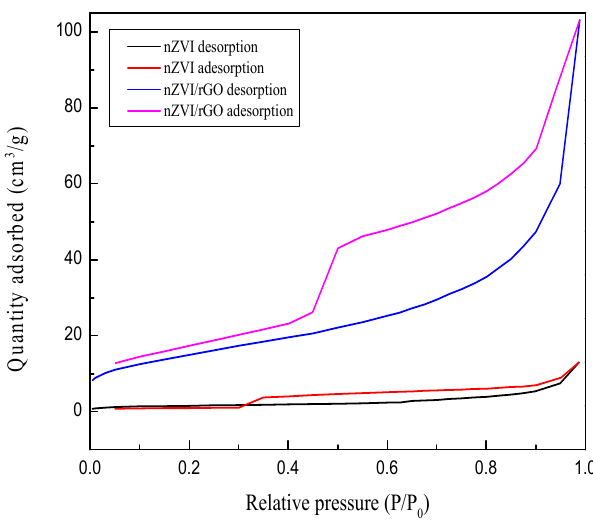
Figure 6. The adsorption/desorption isotherms of nZVI and nZVI/rGO.